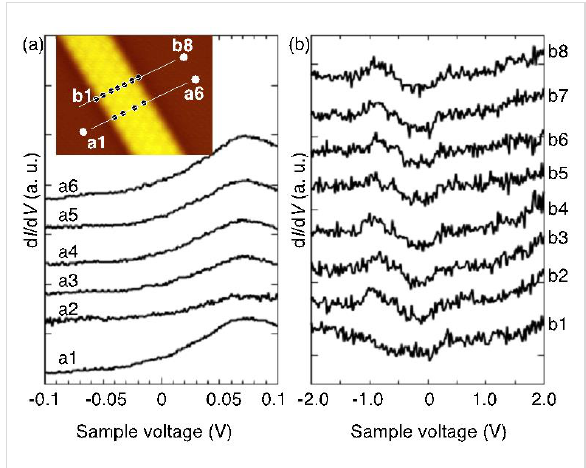
Figure 2: d I /d V spectra acquired in (a) narrow (from − 0.1 to 0.1 V) and (b) wide (from − 2 to 2 V) voltage ranges. The inset of (a) is an STM image showing the tip locations where the spectra are measured. The modulation voltage of 8 mV at 366.6 Hz is added to the sample voltage. Each spectrum is shifted